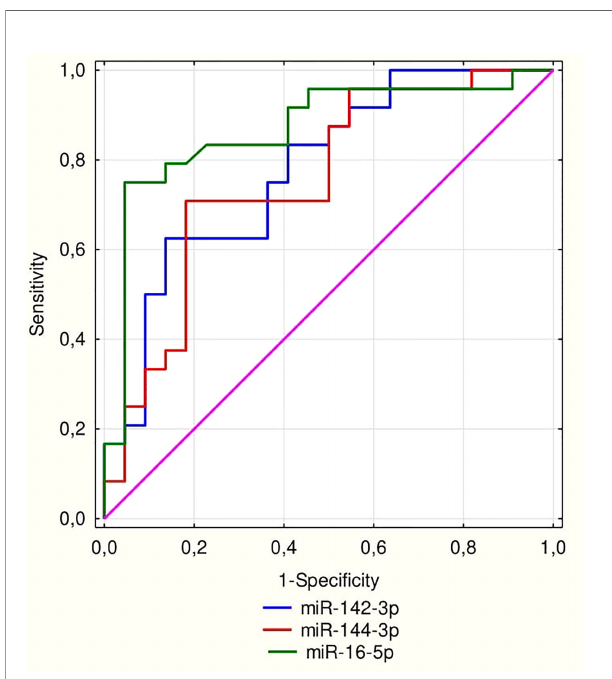
FIGURE 2 | ROC curve for miRNA 16-5p (AUC = 0.868; p < 0.0001), miR-142- 3p (AUC = 0.778; p < 0.0001) and for miR-144-3p (AUC = 0.756; p =